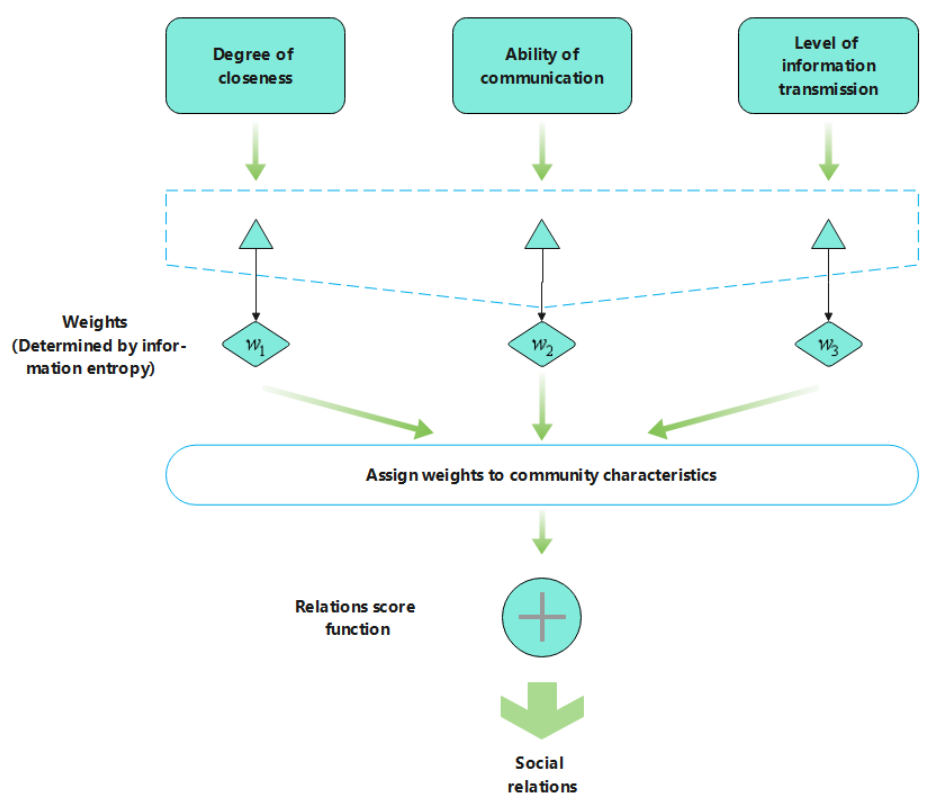
Figure 1. Social relation model.